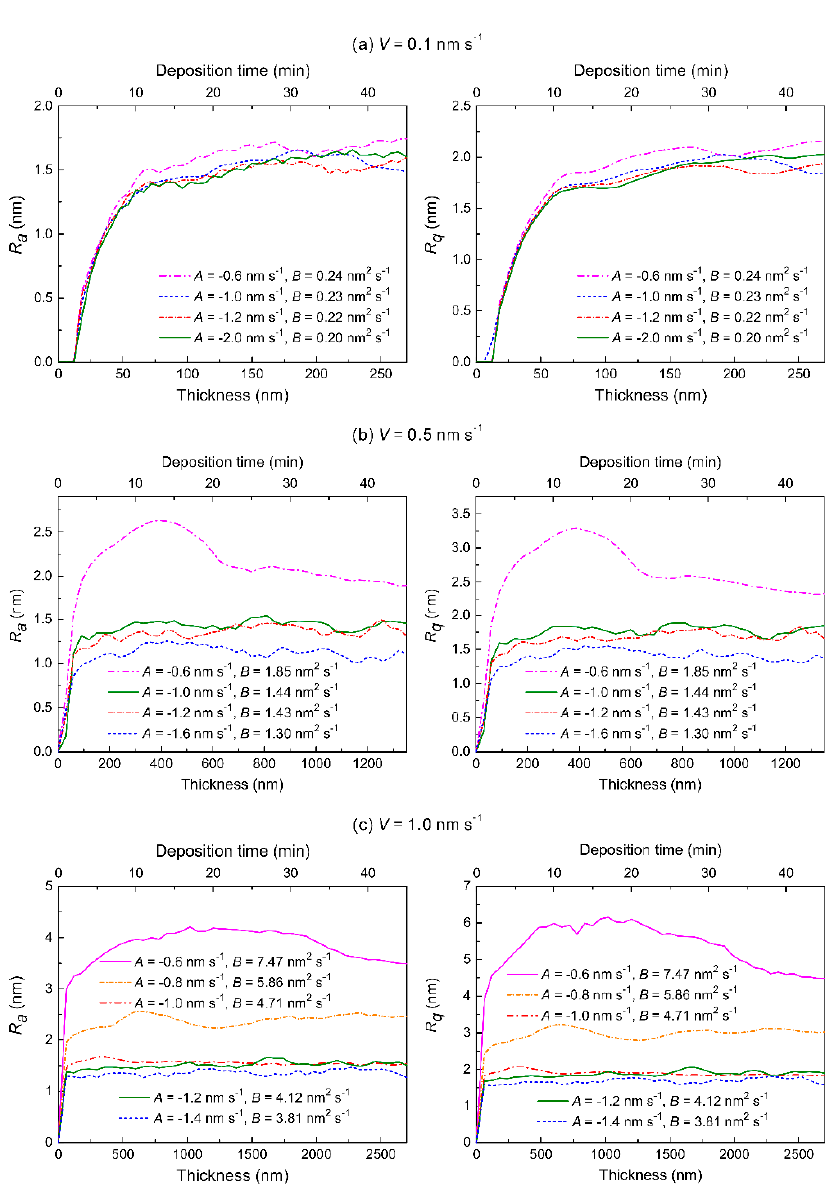
Figure 7. Values of R a and R q for thin films deposited at three different deposition rates of ( a ) 0.1 nm s − 1 , ( b ) 0.5 nm s − 1 , and ( c ) 1.0 nm s − 1 with the corresponding deposition thickness and time.